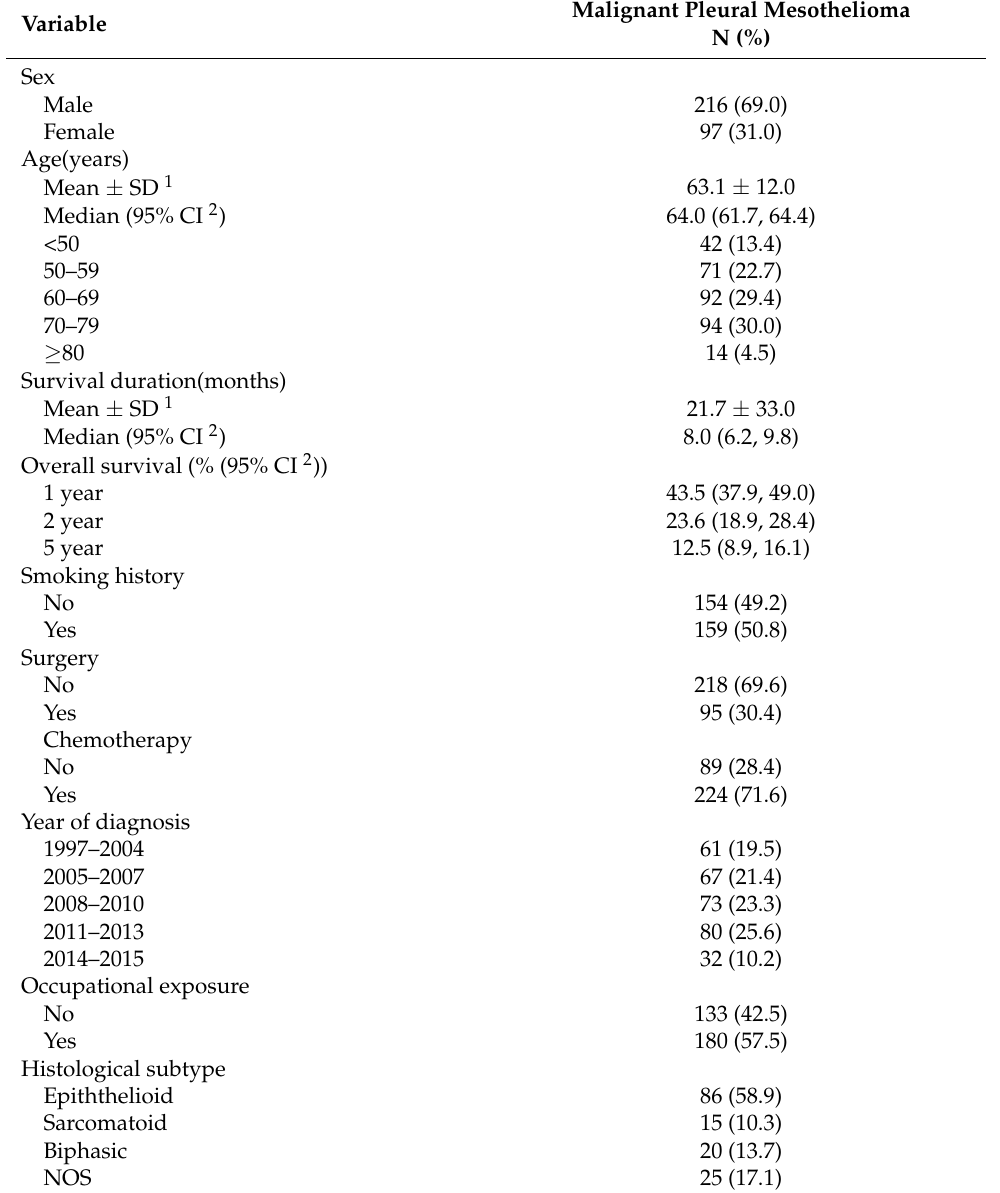
Table 1. General characteristics of the study subjects.